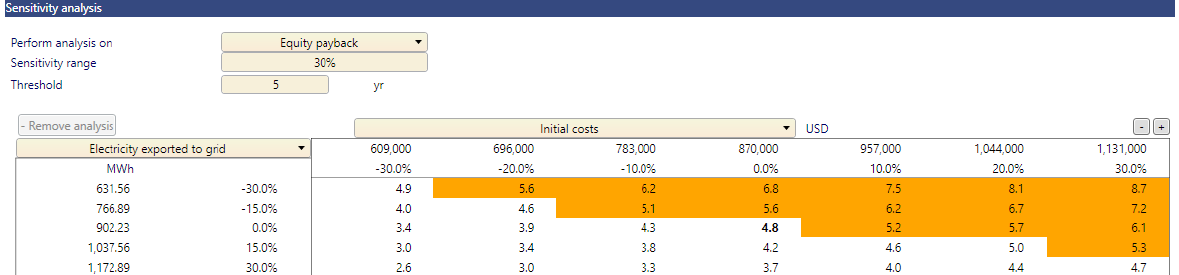
Figure 12. Sensitivity of 650 kW solar–wind RES plant to initial cost and electricity exported to the grid for 0.2 USD/kWh.